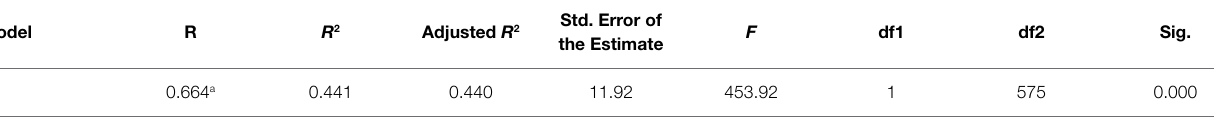
TABLE 3 | Model summary and ANOVA test of linear regression analysis for mindfulness as a predictor of wellbeing. Model